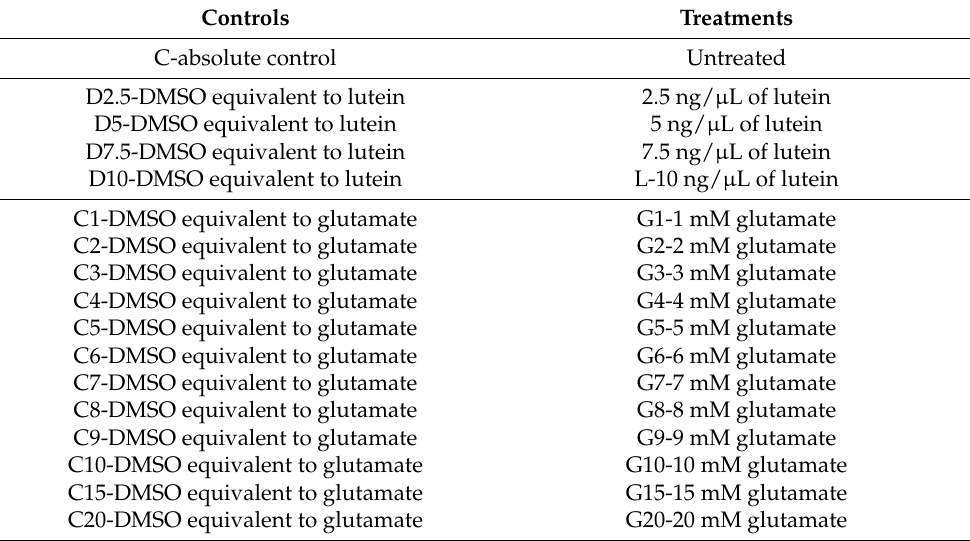
Table 1. Abbreviations of the